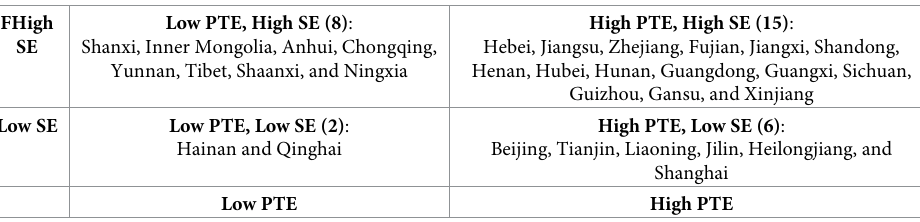
Table 6. Efficiency level distribution of each